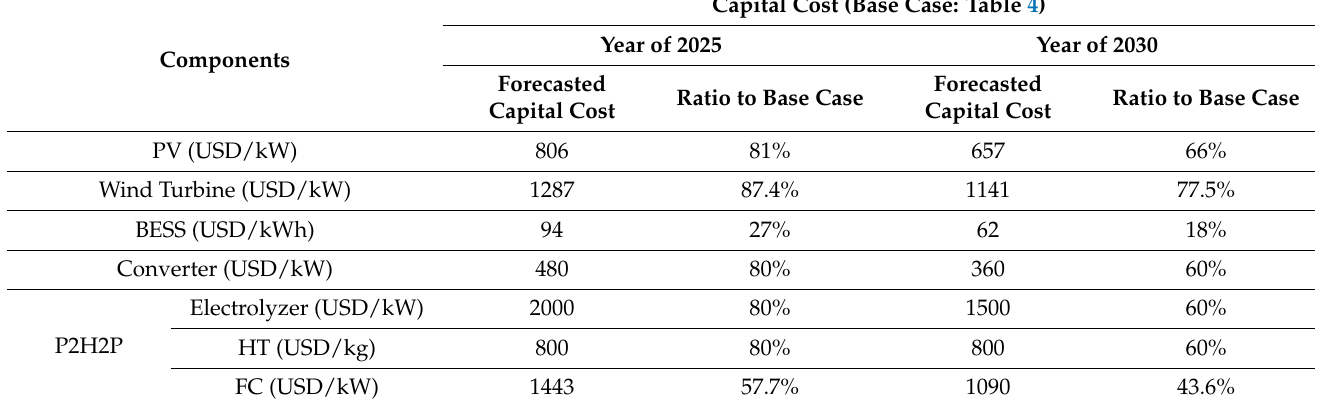
Table 17. Forecasted capital cost in 2025 and 2030.